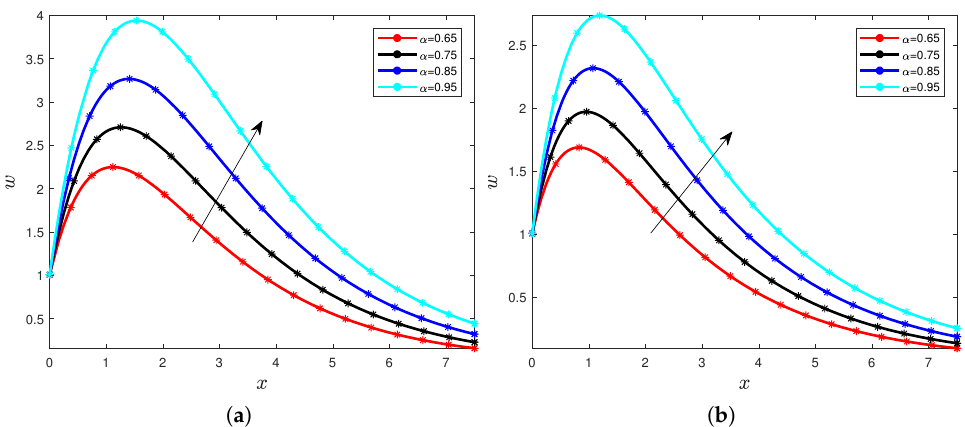
Figure 1. Velocity for different values of the order α with Pr = 5 ( a ) and Pr = 10 ( b ).